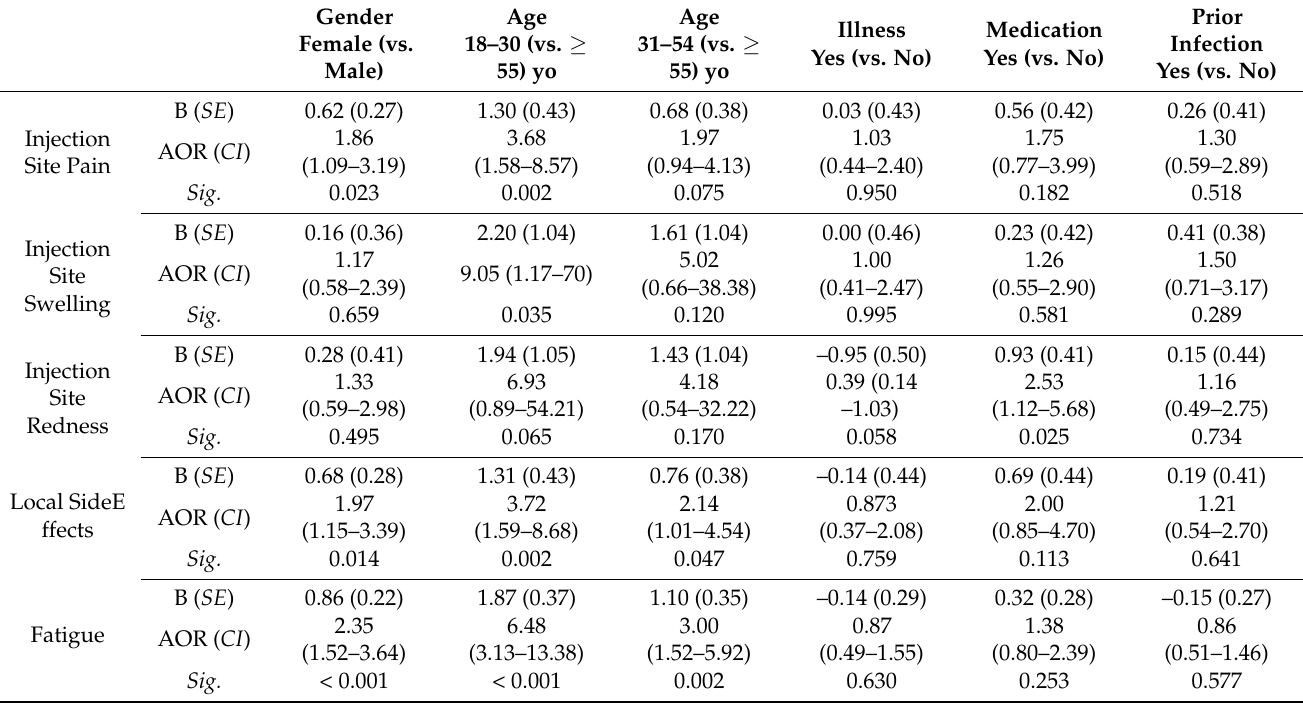
Table 10. Adjusted risk factors of side effects experienced by Slovak healthcare workers who received BNT162b2, February– March 2021 ( n =